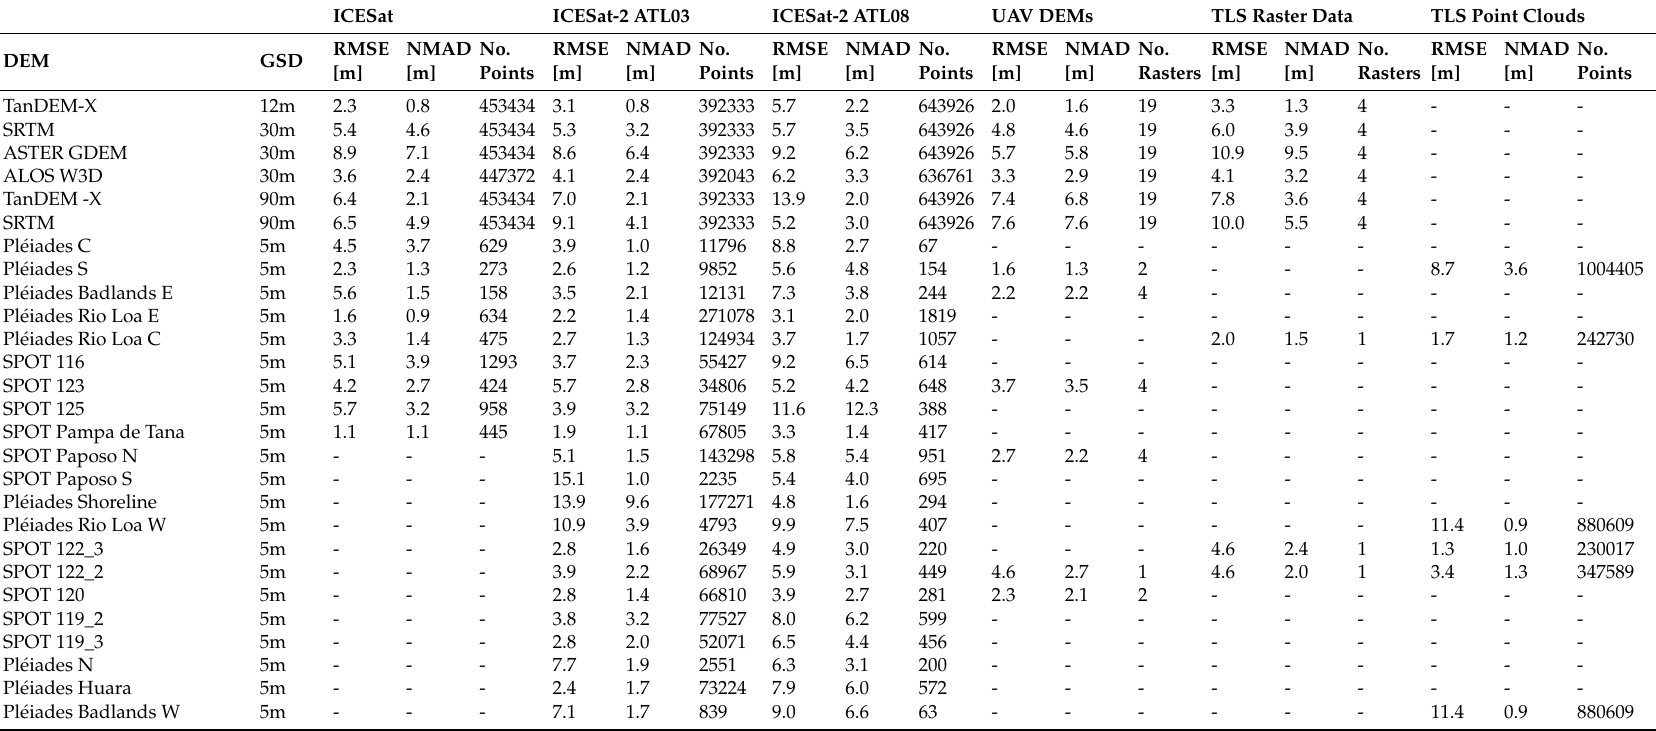
Table A1. Overall accuracies of all digital elevation models compared to the reference point datasets of Ice, Cloud and Land Elevation Satellite (ICESat), ICESat-2 ATL03, ICESat-2 ATL08 and Terrestrial Laser Scanning (TLS) point clouds as well as raster datasets derived from unmanned aerial vehicle (UAV)-based photogrammetry and TLS datasets. Listed are the ground sampling distance (GSD), the calculated root mean square error (RMSE), the normalized median absolute deviation (NMAD) and the total amount of applied points or raster for each